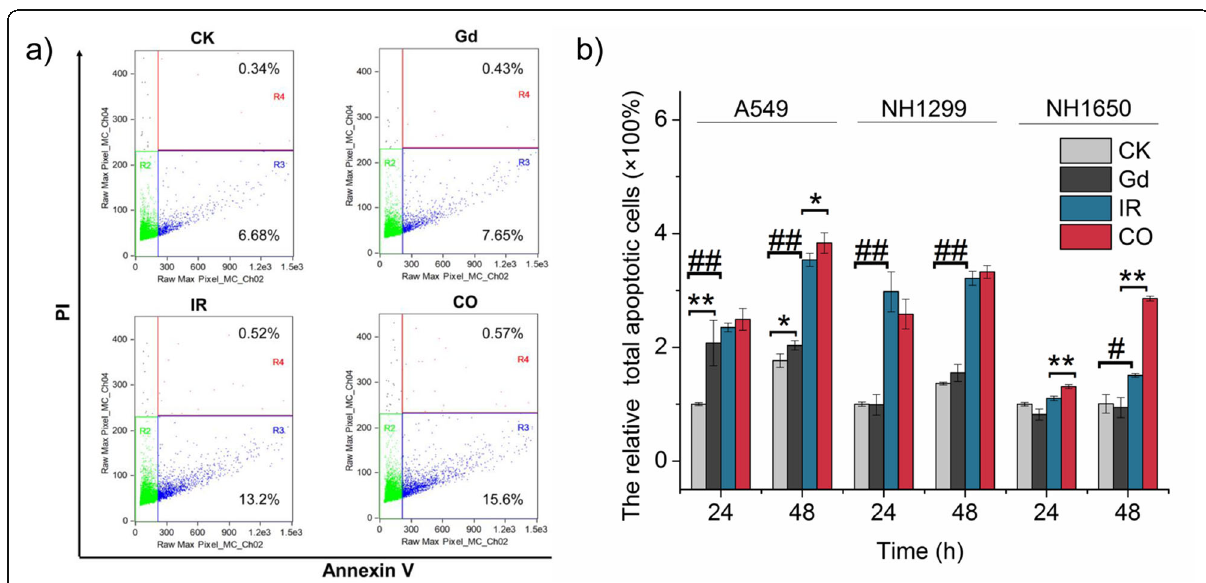
Fig. 5 Marked apoptosis was induced by GONs in A549 and NH1650 cells but not in NH1299 cells. a The flow cytometry images indicating the apoptotic rates of A549 cells at 48 h after carbon ion radiation. b The relative incidence of apoptosis induced by GONs treatment and irradiation. * p < 0.05 or ** p < 0.01 represent statistically significant or extremely significant differences, respectively, induced by GONs. Similarly, # p < 0.05 or ## p < 0.01 indicated significant or extremely significant differences, respectively, owing to